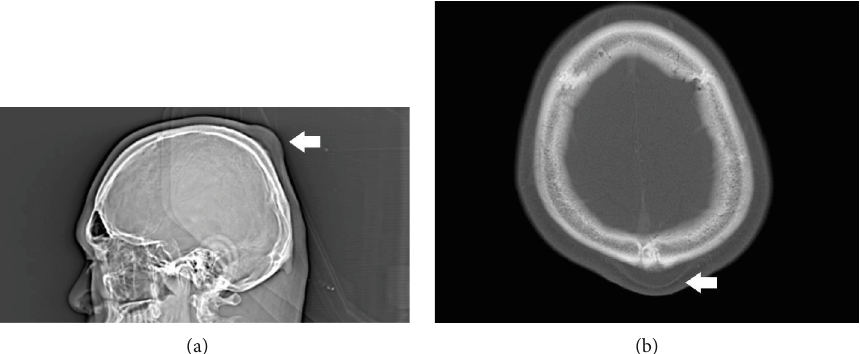
Figure 1: Computed tomography of the cranium showing a posterior scalp mass at the midline near the convexity: (a) sagittal view; (b) transverse view: 3.7cm at the greatest